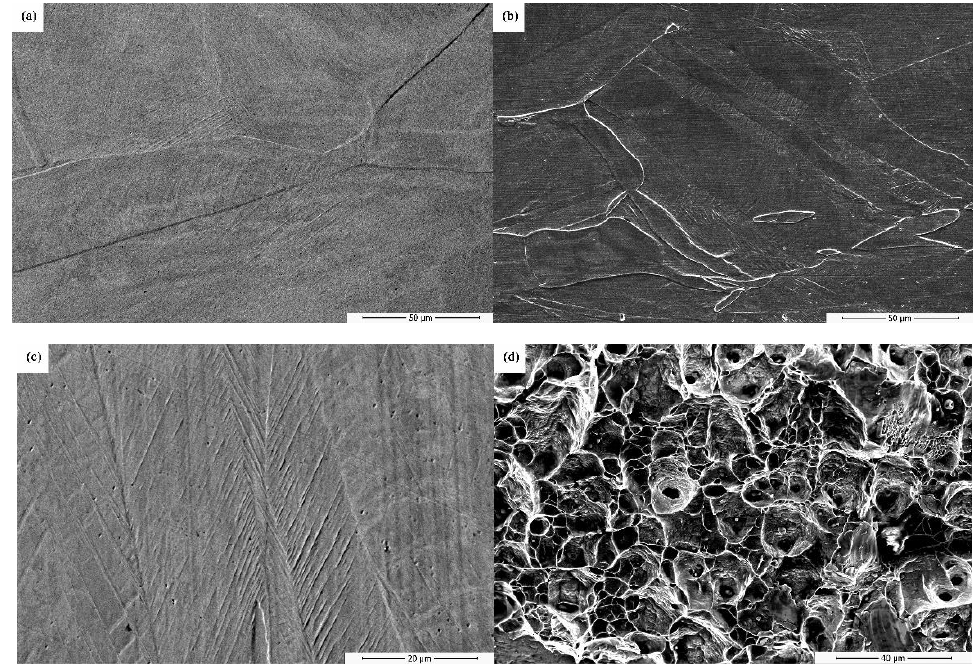
Figure 3. Micrographs of steel at different strain. ( a ) 0%; ( b ) 30%; ( c ) after failure at 68%; ( d ) tensile fracture.